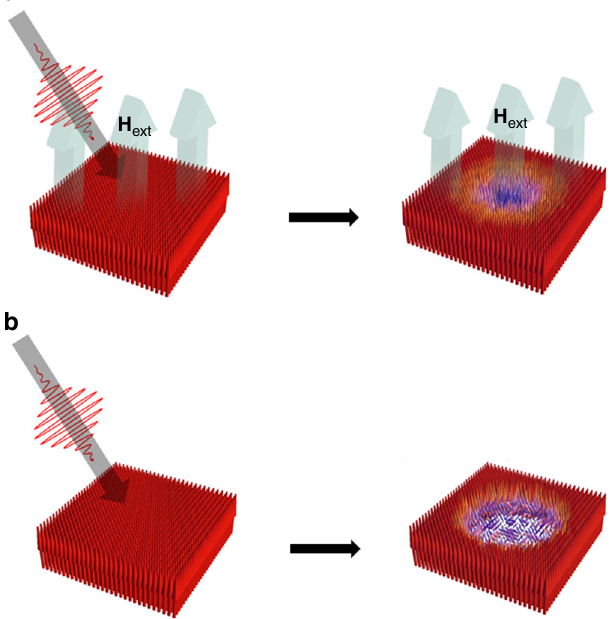
Fig. 1 Schematic diagram of the ultrafast magnetic cooling effect. a Upwardly saturated initial spin moments under an external magnetic fi eld ( H ext ) before a laser pulse excites the sample (left). Laser pulse propagation direction is represented by gray arrow. Demagnetized state after a laser pulse hits the sample under H ext (right). b Upwardly saturated initial spin moments before a laser pulse excites the sample (left). Demagnetized state after a laser pulse hits the sample under zero external magnetic fi eld